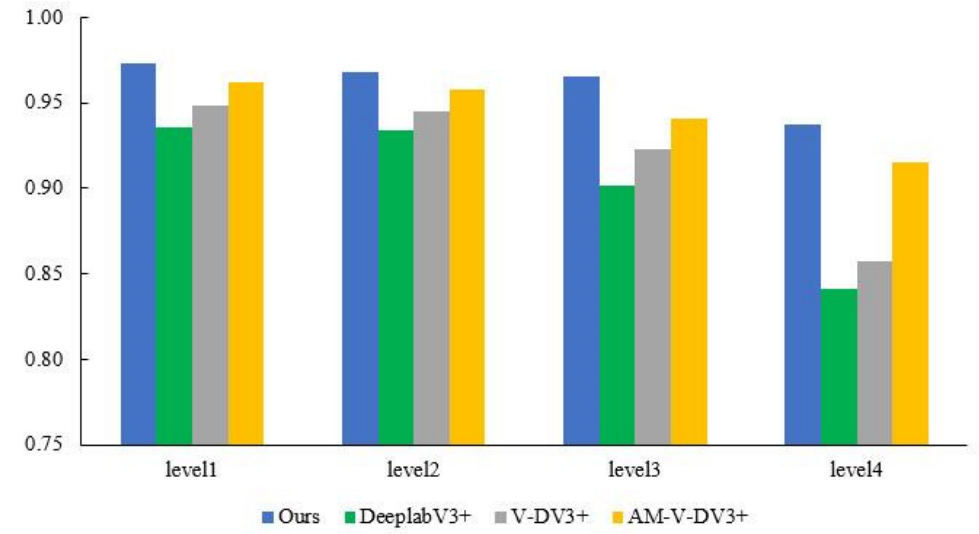
12 of 16 Table 3. The results of comparative experiments of Accuracy of different Models. Model